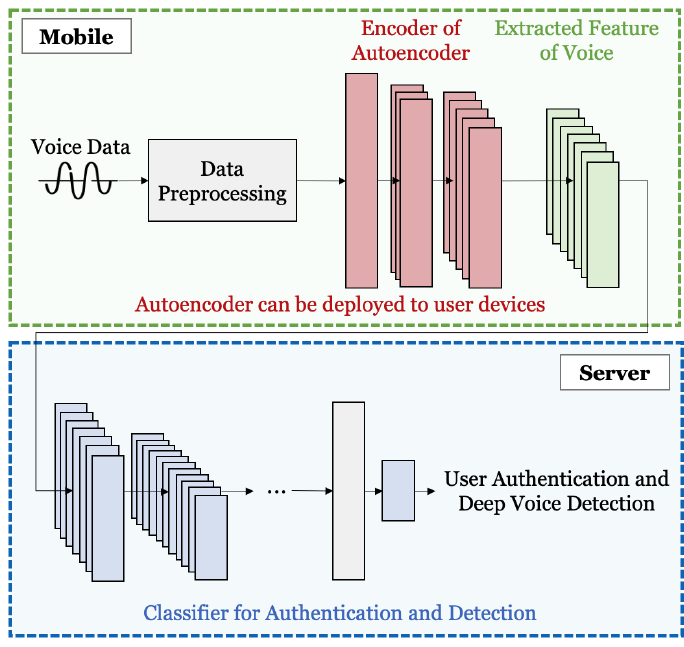
Figure 2. Diagram of proposed method.